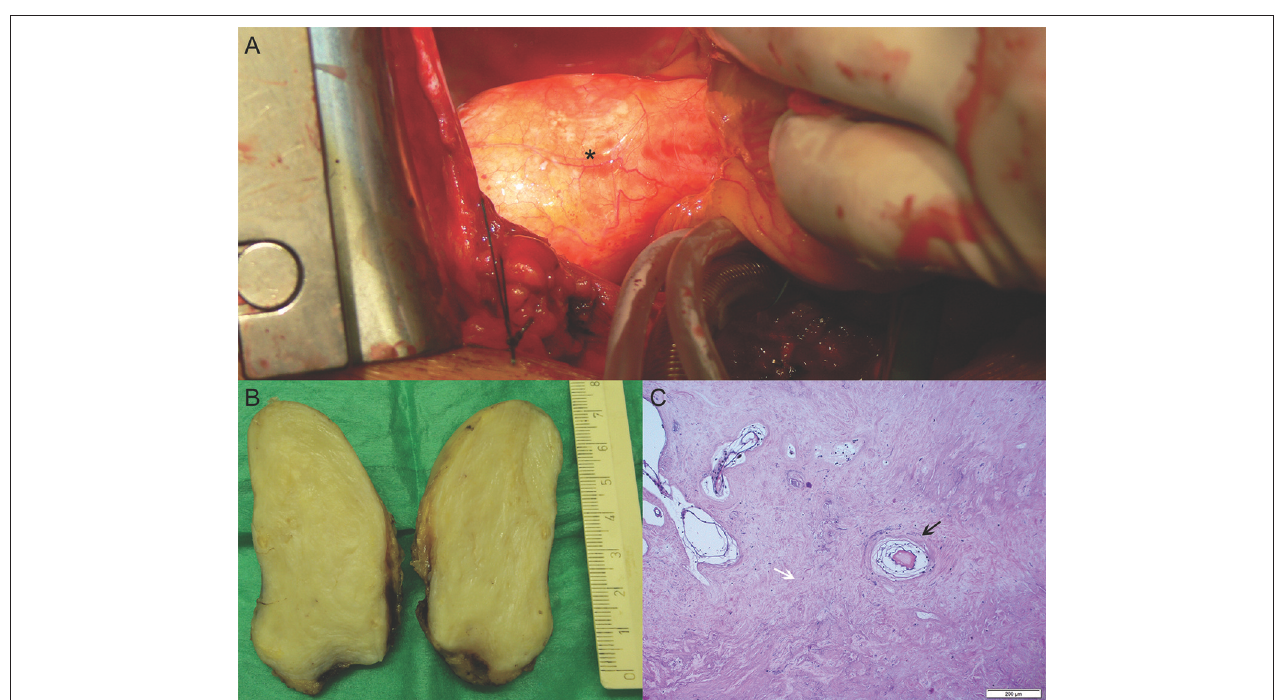
FIGURE 3 | Intraoperative image and histopathology of the tumor. (A) Cardiac surgery. Transverse intersection of the aorta and the pulmonary trunk exposed the intrapericardial tumor (asterisk). (B) Macroscopic section of bisected mass. The scale indicates its longitudinal dimension of 75mm. (C) Microscopic section. Hematoxylin and eosin-stained histology image of the tumor. A blood vessel surrounded by myxoid cells (black arrow). Microcalcifications and degenerative changes are embedded in profuse hyalinized stroma (white arrow).